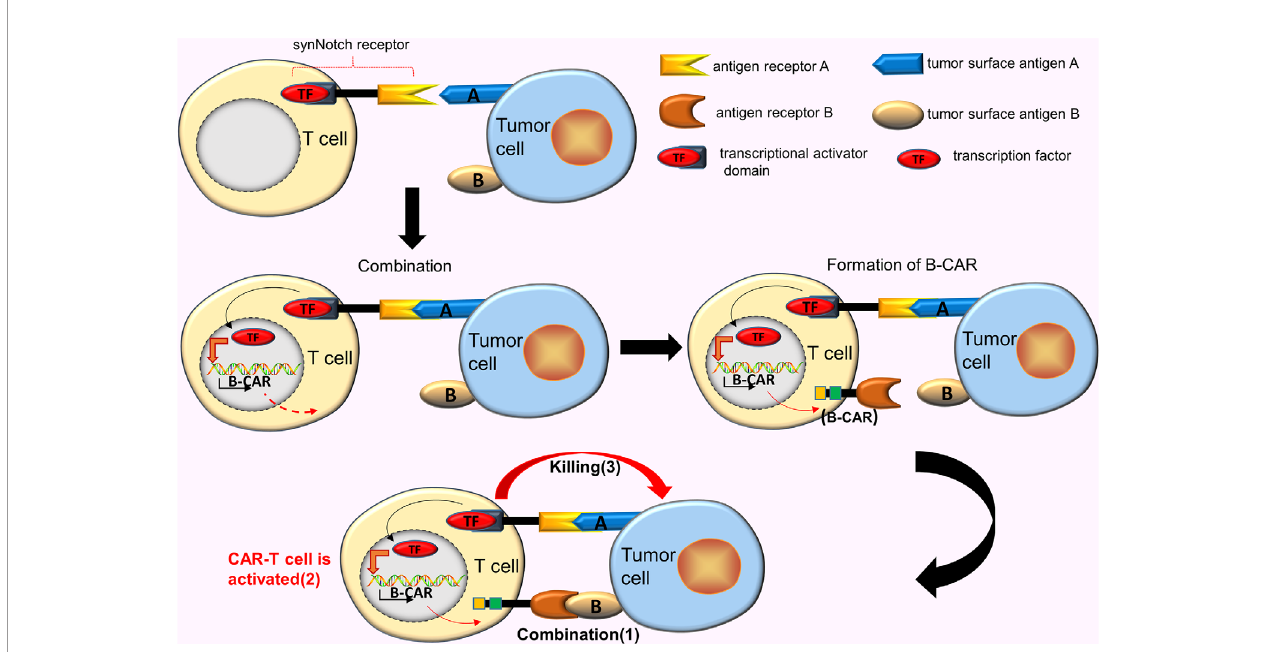
FIGURE 3 | AND gate CAR. SynNotch receptor uses the scFv to bind to the corresponding target antigen A, however, the combination of 2 does not trigger the T cells activation. This binding causes the synNotch receptor to split and release the transcriptional activator domain, which enters the nucleus and drives the expression of another B-CAR gene. Subsequently, the surface of the T cell will express B-CARs. At this time, the newly expressed CARs binds to the target antigen B, activating the T